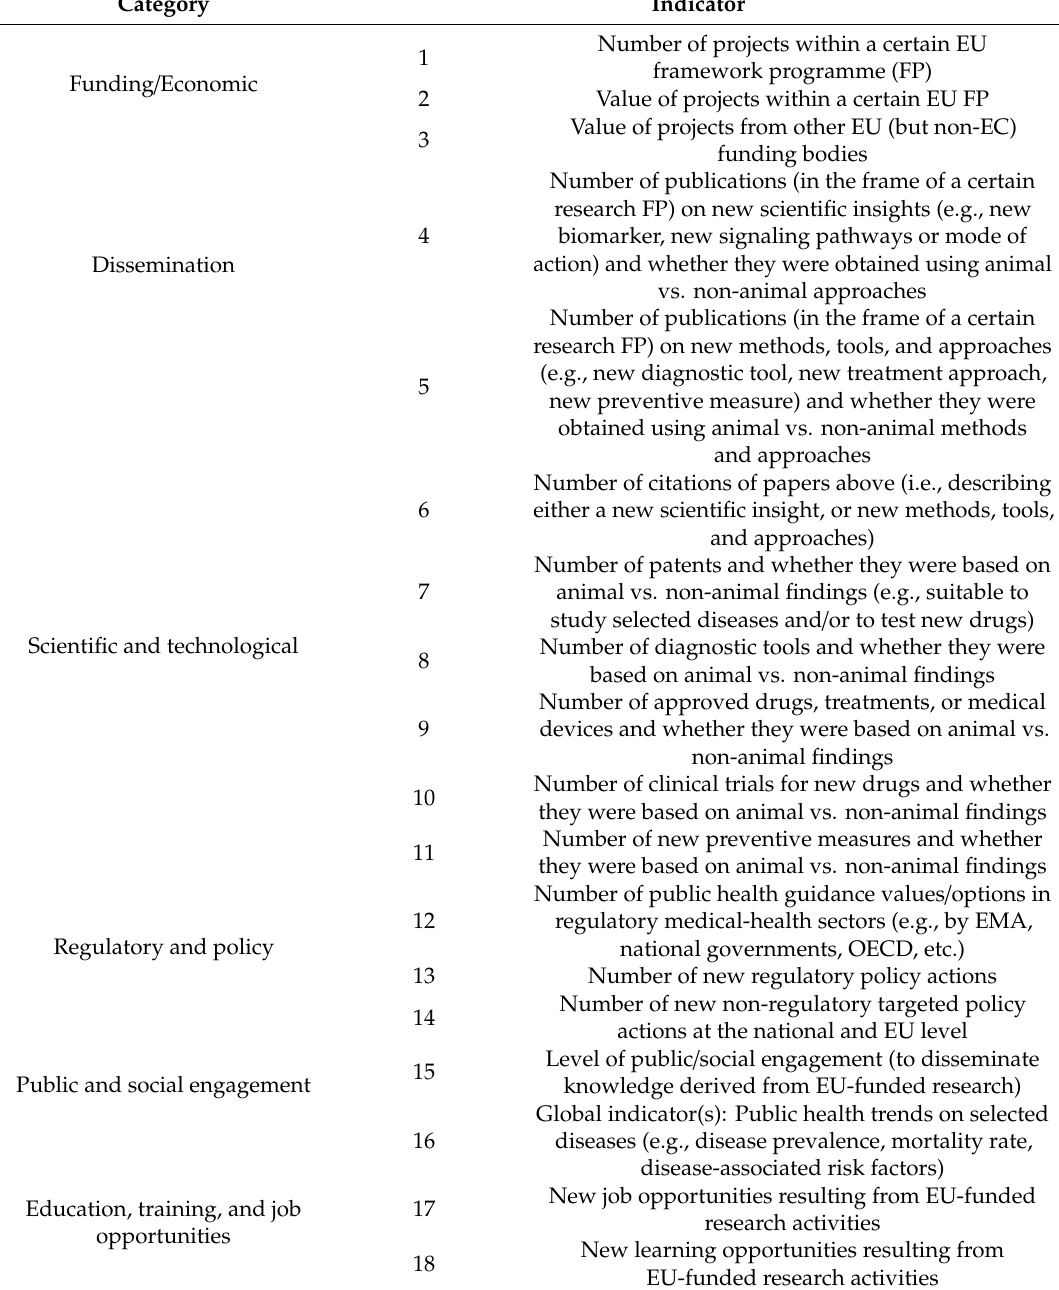
Table 2. Proposed list of 18 indicators to measure the outputs and impact of EU-funded biomedical research activities on selected biomedical research